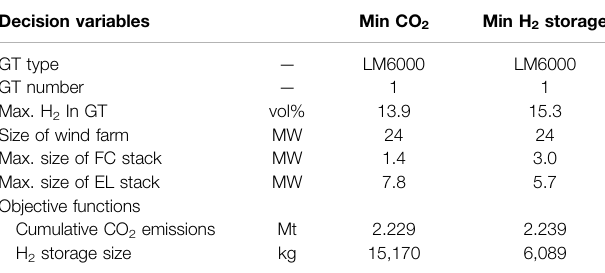
TABLE 4 | Optimal designs of the reference case - Pareto